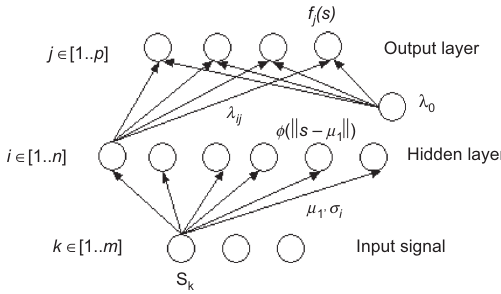
Figure 1. Architecture of an RBF